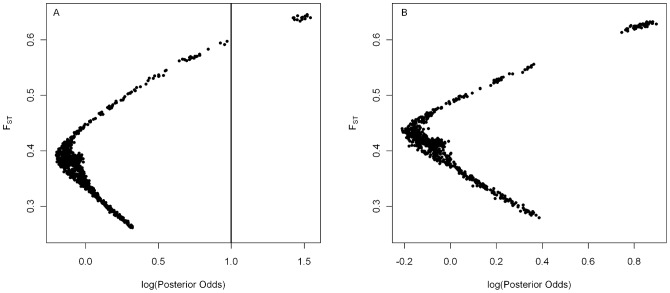
FST outlier locus identification.Locus-specific FST plotted against the posterior odds of the model including locus-specific selection effects versus the model excluding locus-specific selection effects, for A) P24(XY)-east vs. viatica17-east: the cluster of loci to the right of the vertical line at log(PO) > 1 are the 14 loci classified as significant outliers from this population pair, and B) P24(XY)-north vs. viatica17-south: the cluster in the top right corner includes seven loci which are also significantly differentiated in the P24(XY)-east vs. viatica17-east pair.